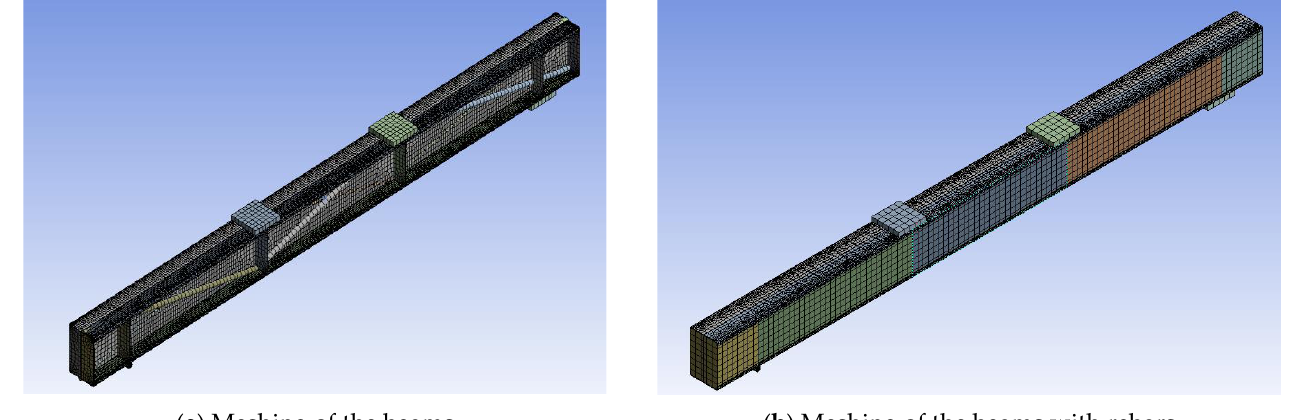
Figure 19. Meshing of beams used in the FE model.